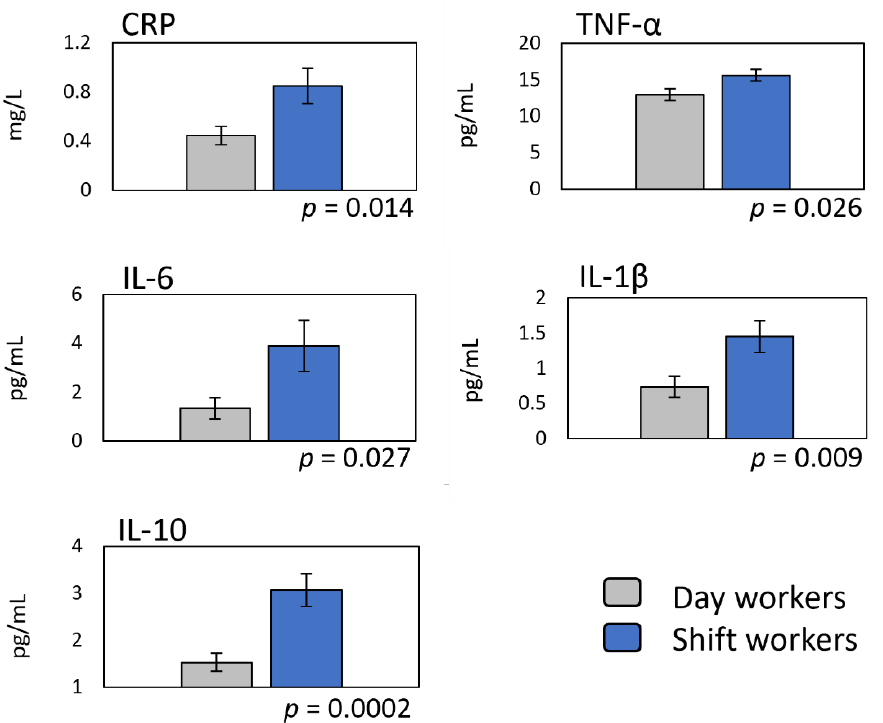
Figure 2. Changes in distinct markers of systemic inflammation as a function of shift-work exposure. Data ( n = 104; 57 shift workers) represent group means ± standard error. Differences were assessed by the student’s t -test for independent samples. Respective p values indicate statistical significance.